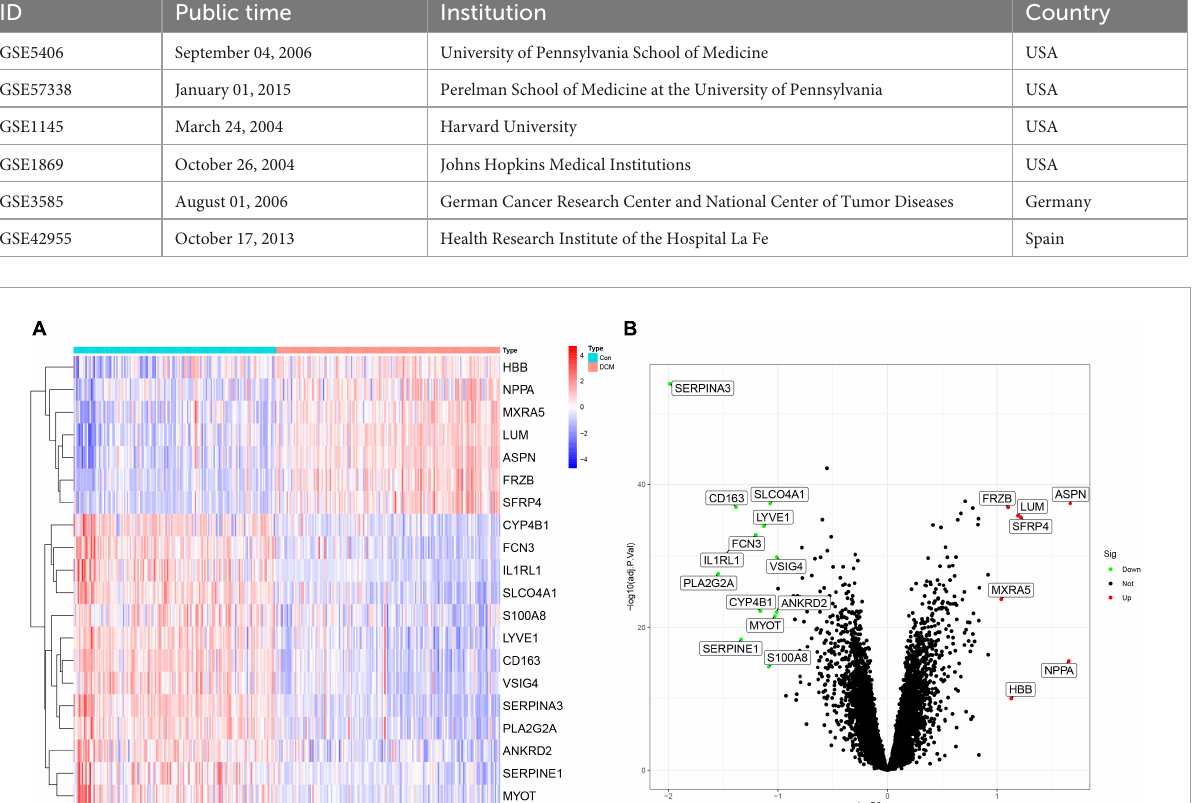
TABLE 1 Basic information on the six microarrays.